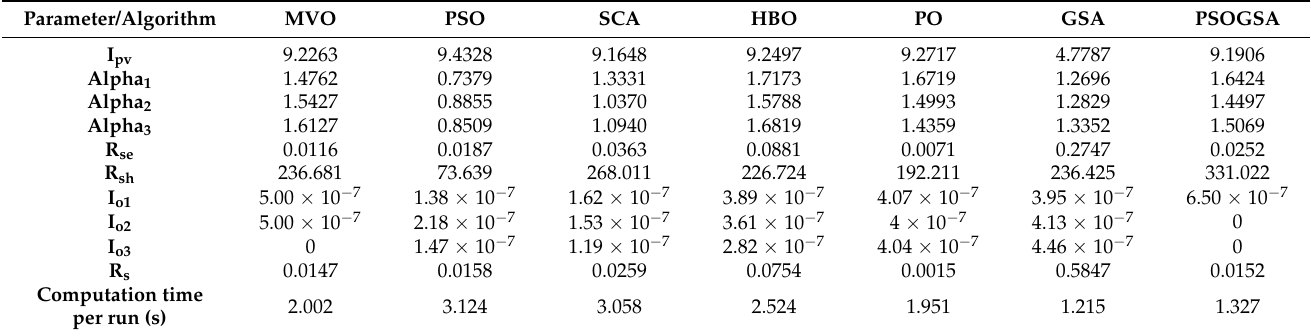
Table 8. The monocrystalline MTDM parameter estimation